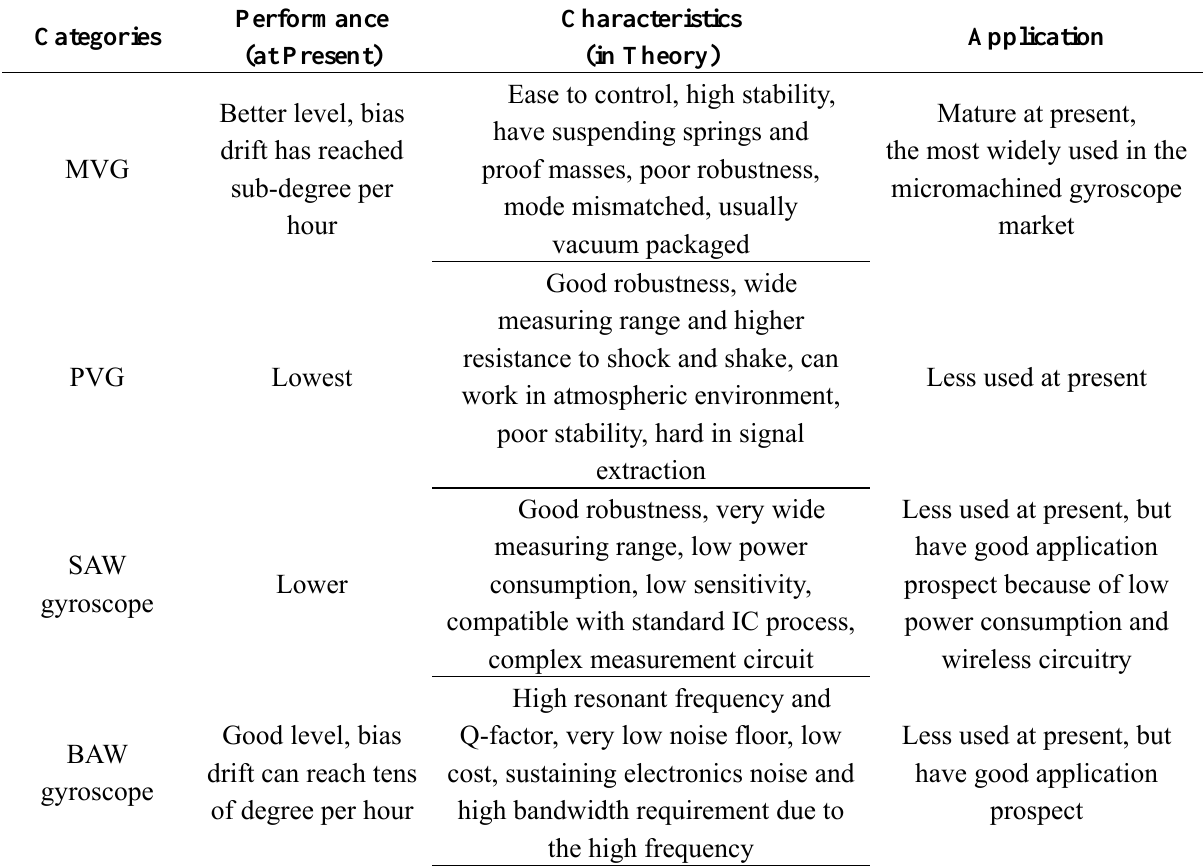
Table 13. Comparison of some typical kinds of micromachined gyroscopes.